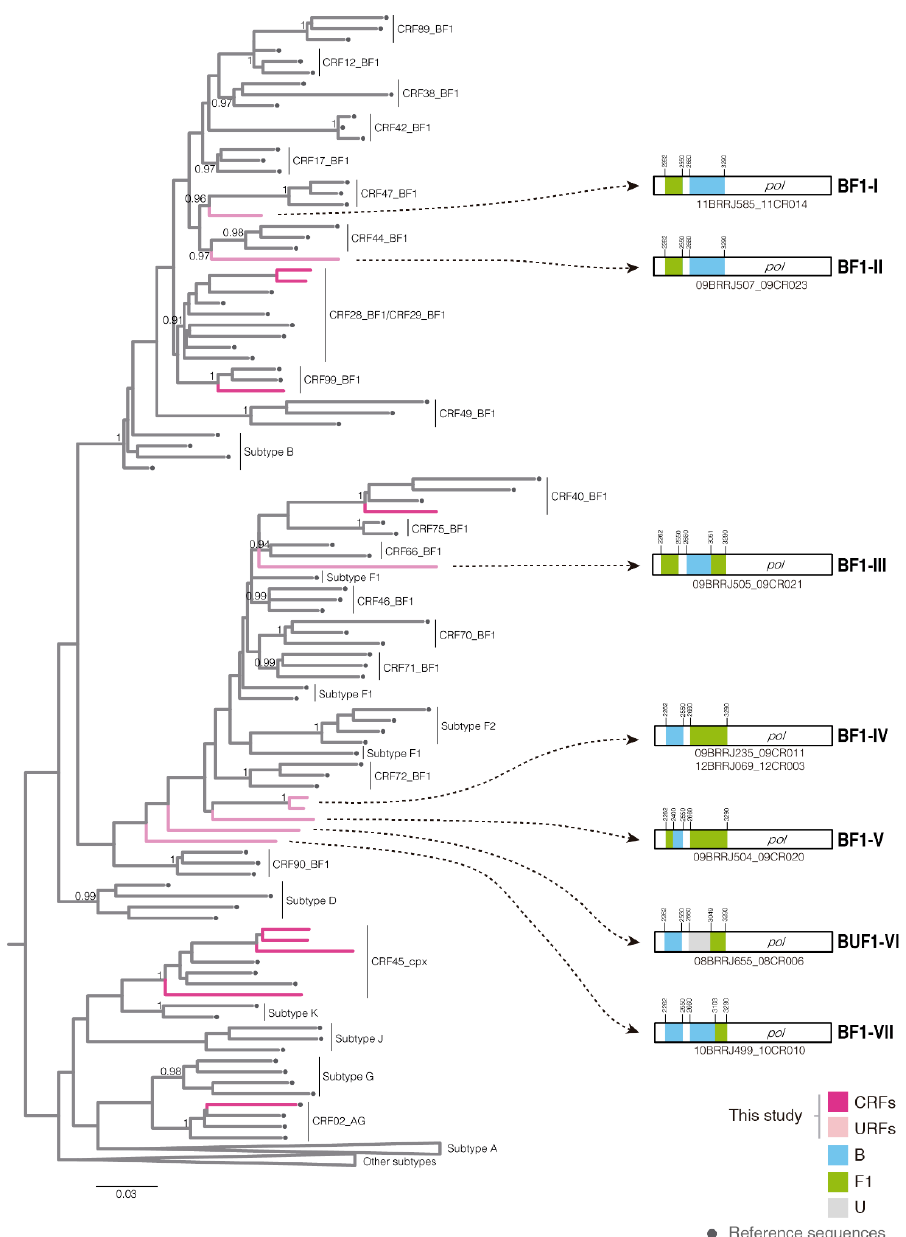
Figure 2. Maximum likelihood tree of the pol (PR/RT) region of HIV-1 infected children and adolescents from Rio de Janeiro classified as recombinants. Gray circles indicate reference sequences of all CRFs included. CRFs clusters were indicated by gray vertical lines. Some branches were collapsed for visual clarity. The branches of the sequences classified as CRFs were colored dark pink while those classified as URFs were colored light pink. The aLRT values are shown at key nodes and the scale represents number of substitutions per site. Schematic drawing showing breakpoint pattern at the pol (PR/RT) region of each URF lineage were showed in the right, using the color scheme indicated in the legend. The rectangles represent the whole pol gene, while the colored boxes indicate the position of the PR/RT sequences obtained in this study and the genomic positions (relative to the HXB2 reference sequence) of the recombination breakpoints.